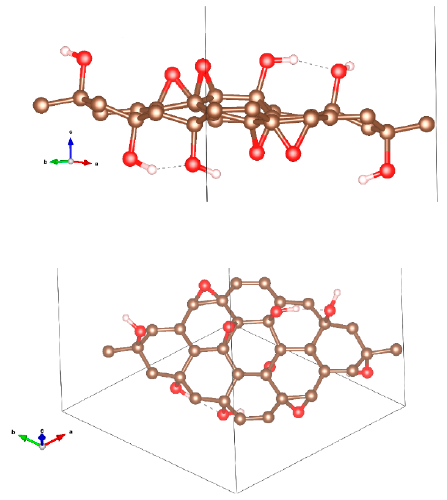
Figure 1. Lateral and top view of optimized structure of the graphene oxide (GO) supercell (brown: C, red: O, and white: H atoms).